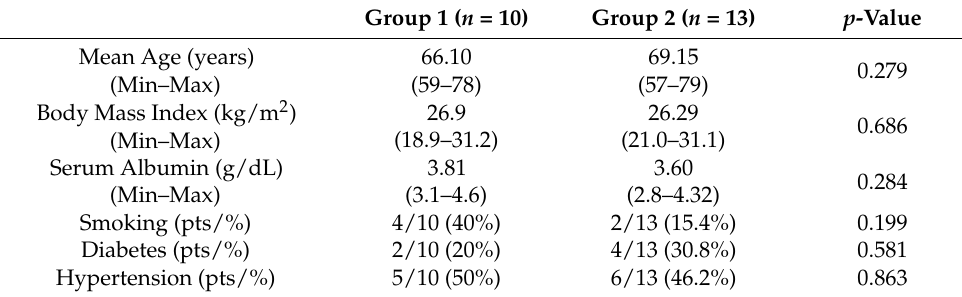
Table 2. Patients’ comorbidities and high-risk features.